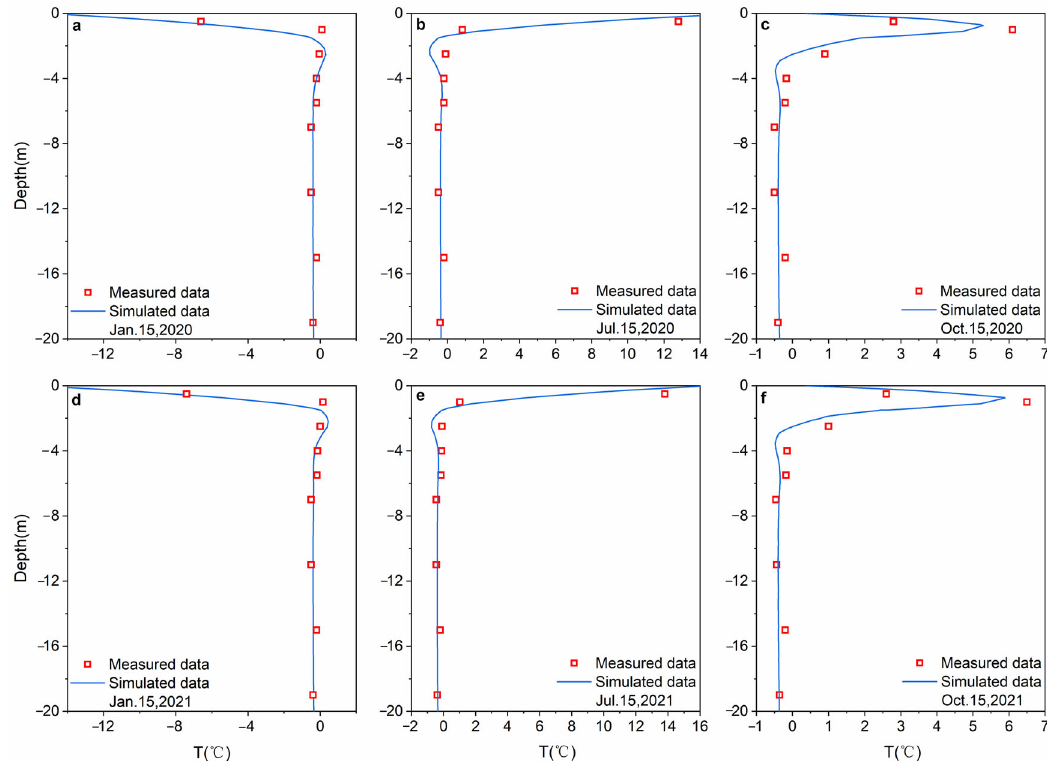
Figure 6. Comparison between the measured and simulated ground temperature values at the 1 m